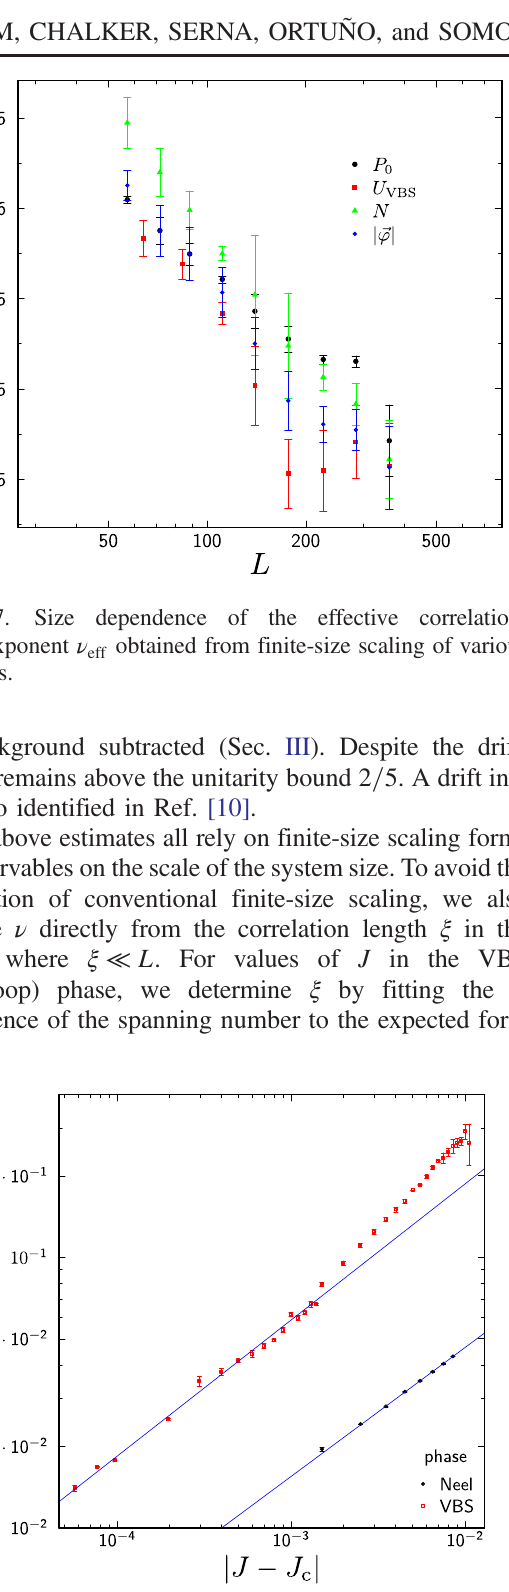
FIG. 18. Estimates of the correlation length obtained from (1) the exponential decay of the spanning number N in the VBS s (red points) and (2) the coefficient of the linear phase, J > J c growth of N in the Néel phase, J < J (black points). Note: The s c overall normalization is arbitrary in the latter